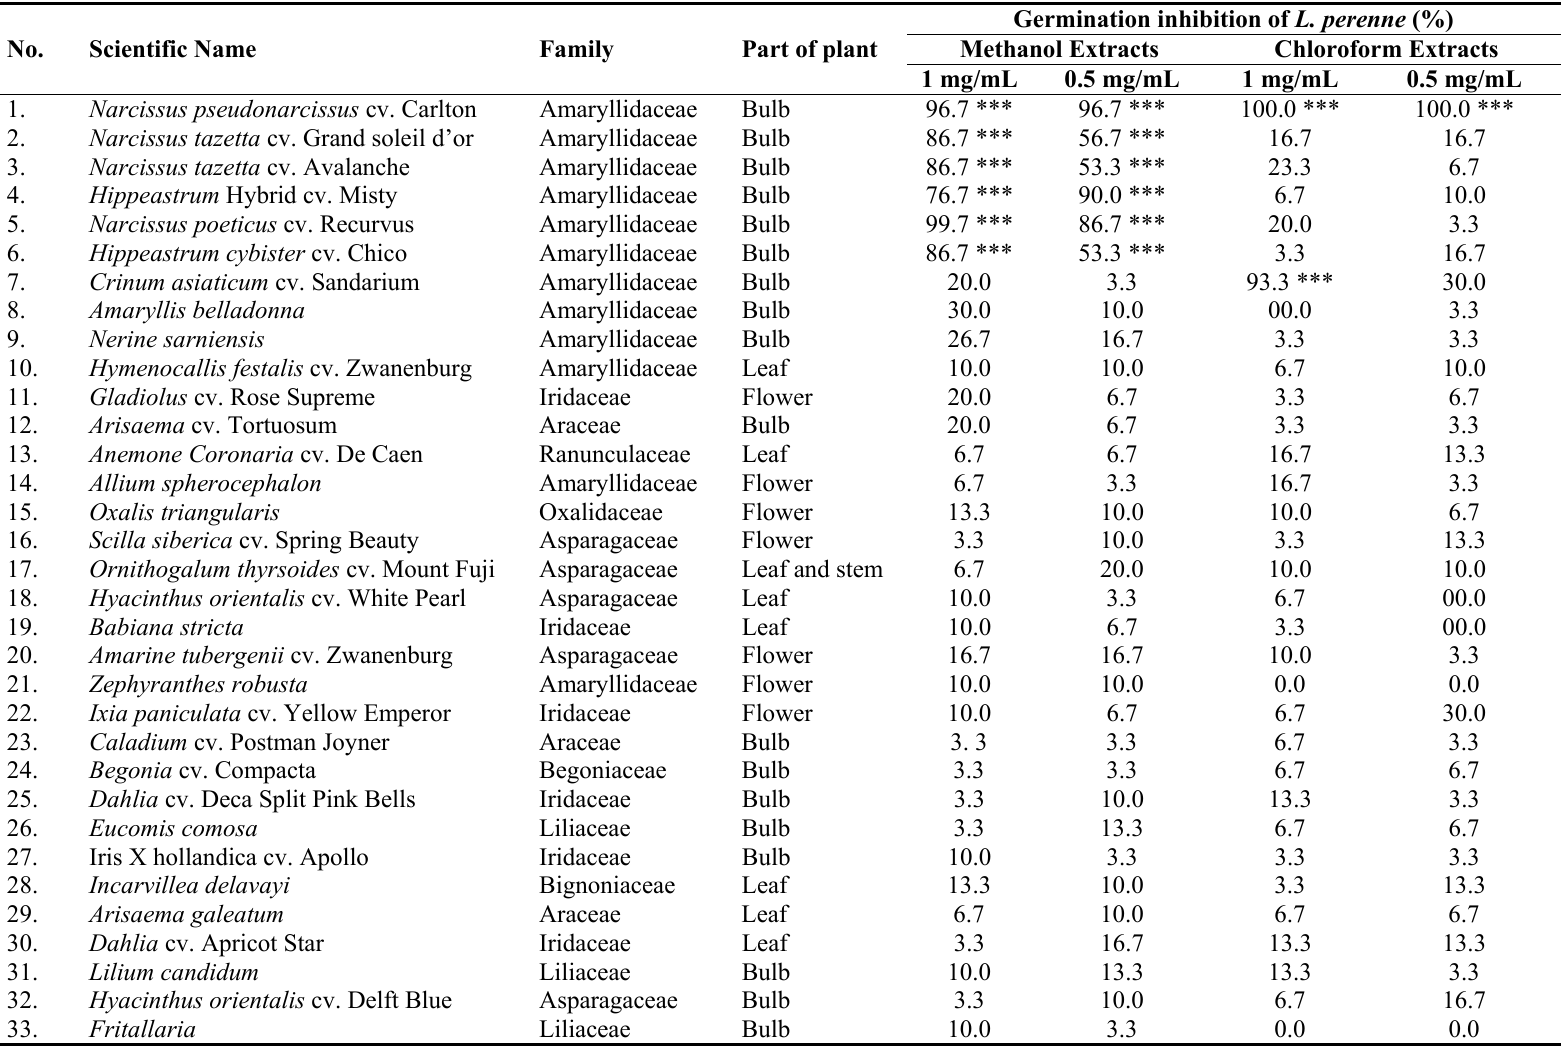
Table 1. The effect of methanol and chloroform extracts, derived from 33 flower bulb species, on Lolium perenne seed germination at concentrations of 0.5 and 1.0 mg/mL. Data present the mean of three replicates. Significant inhibition is indicated as: *** p ≤